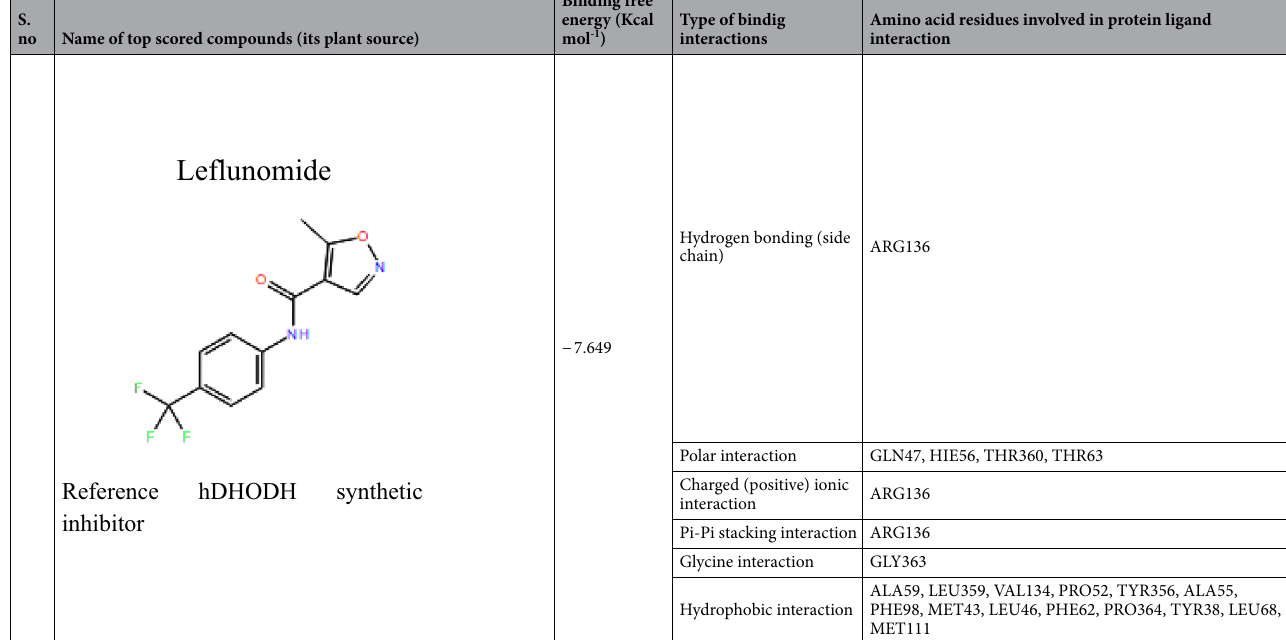
Table 1. Free binding energies of the top 20 scoring hits and their plant source along with the co-crystalized ligand, leflunomide and the reference drug, brequinar, obtained through molecular docking with hDHODH crystal structure (3G0U), in addition to, types of binding interactions between ligands and critical amino acid residues in the hDHODH binding site.